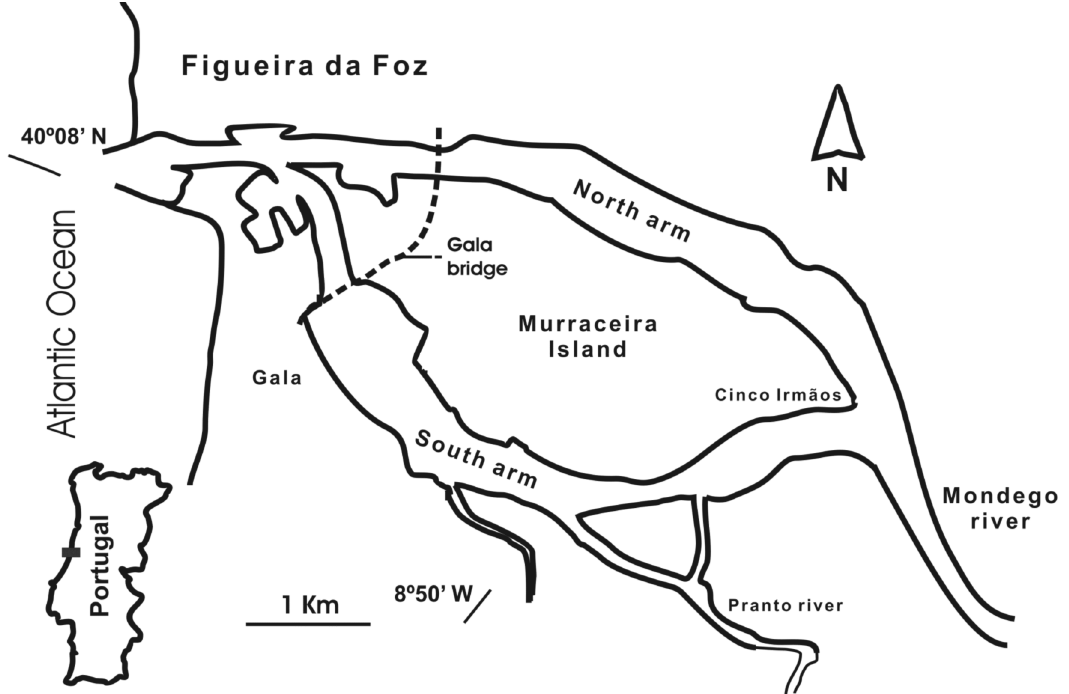
Fig. 1. Location map of Mondego